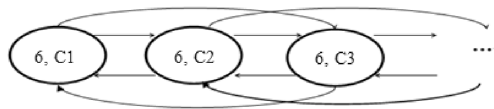
Fig. 7. Annual energy consumption transition